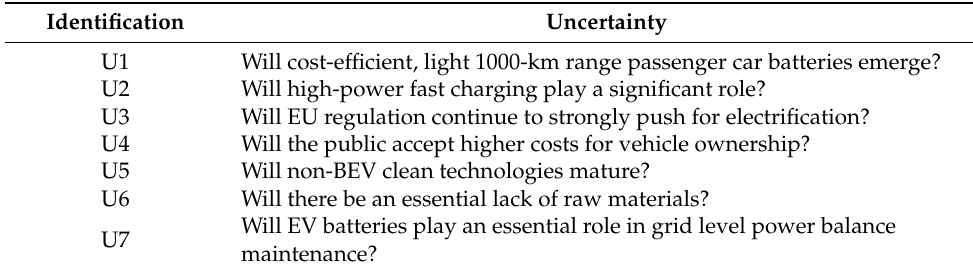
Table 2. Uncertainties identified by experts in this